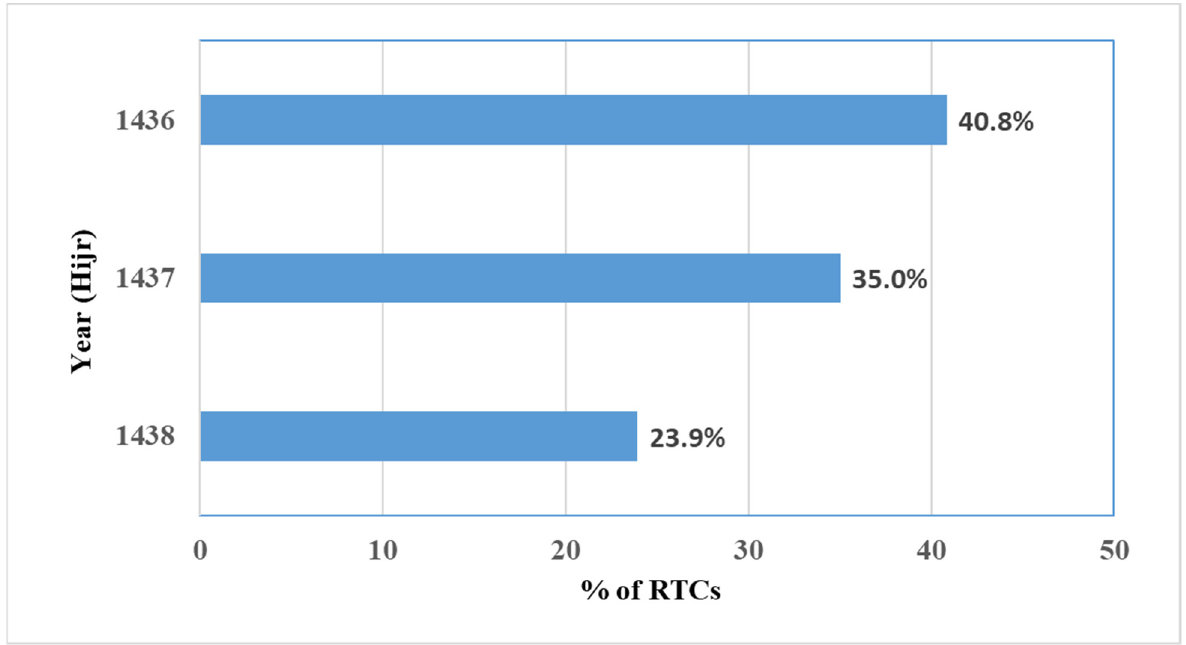
Figure 4. Chronological trend of serious injury and fatal crashes in the research area (adopted from [65]).